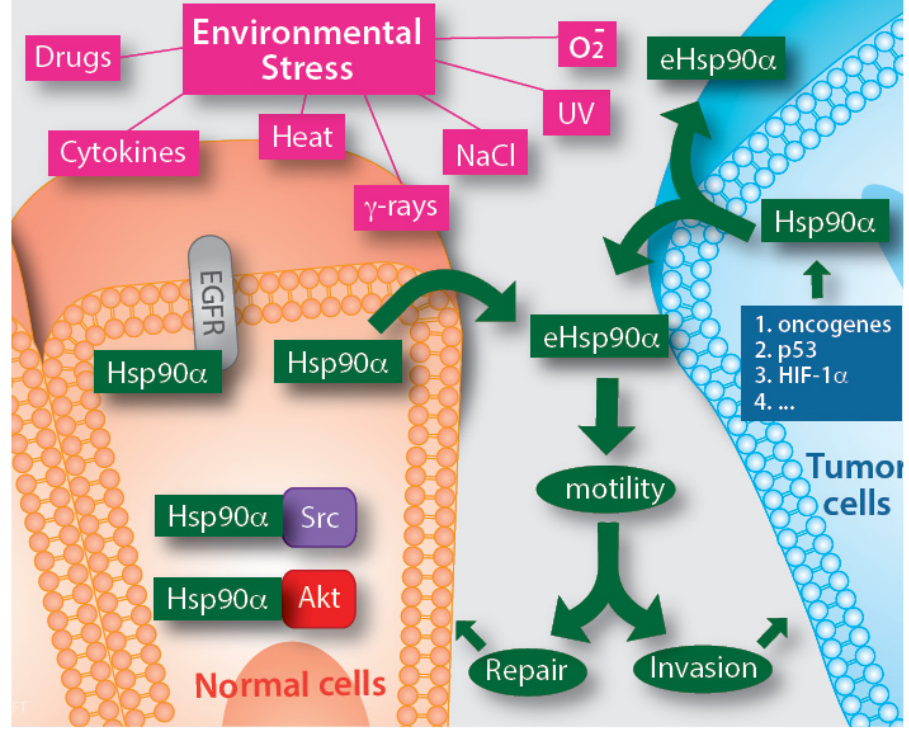
Figure 2. Secretion of eHsp90 α by normal cells under medically defined stress and by tumour cells driven by oncogenic signals. Almost all kinds of medically defined stresses have been shown to trigger eHsp90 α secretion in a wide variety of cell types. Tumours have either constitutively activated oncogenes or mutant tumour suppressor genes that each triggers eHsp90 α secretion even in the absence of environmental stress cues. The mechanisms by which the stress and oncogenic signals cause Hsp90 secretion remain largely unstudied, in which exosome-mediated secretion of Hsp90 α only accounts for 10% of the total secreted Hsp90 α in both normal and tumour cells. The reported optimal working concentration for the full-length eHsp90 α protein was around 3–10 µ